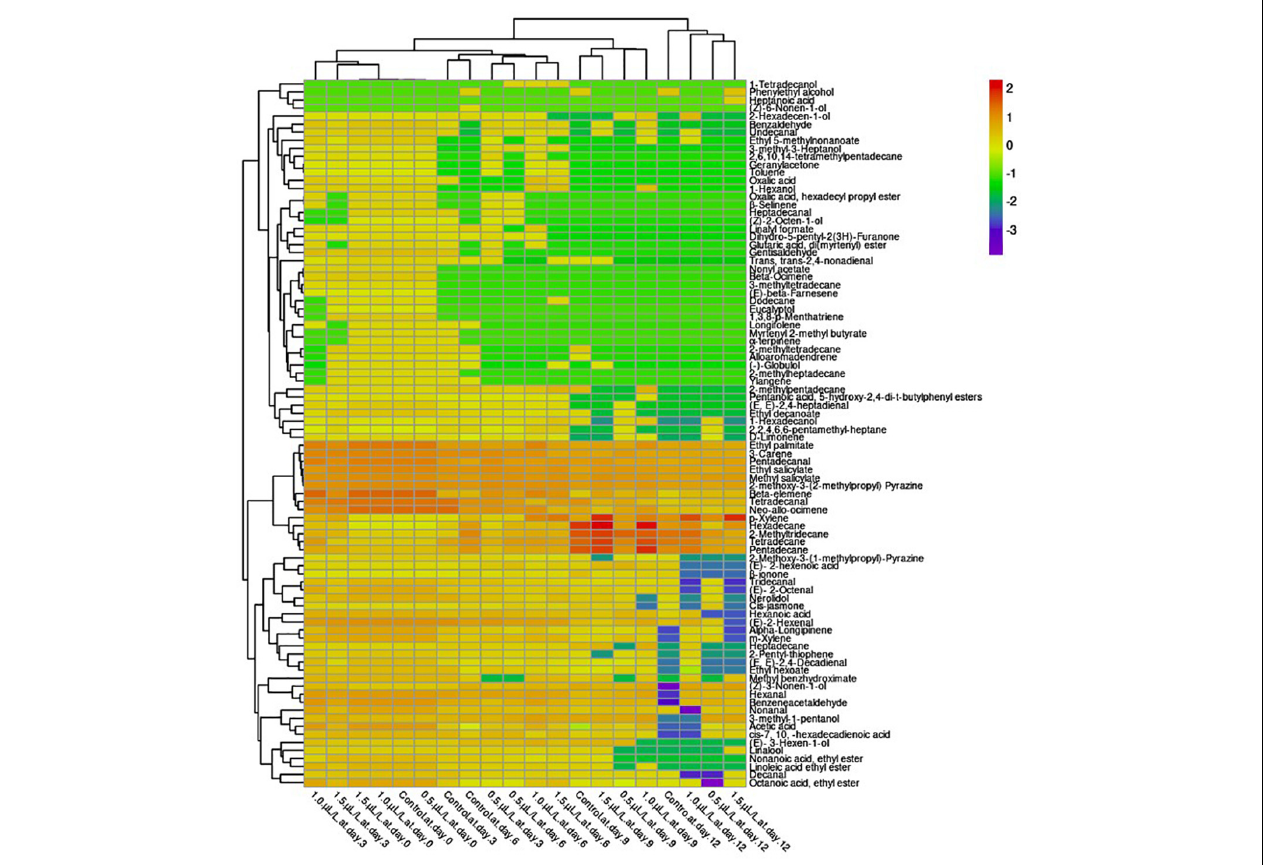
FIGURE 2 | Hierarchical clustering of a heat map showing the changes in the volatile compounds of “Hangjiao No.2” chili peppers under the influence of different concentrations of 1-MCP (0.5, 1.0, and 1.5 µ l L − 1 ) and control during 12 days of storage period. The different treatments were shown in columns. Volatile compounds were plotted in rows. The color box indicates the abundance of each